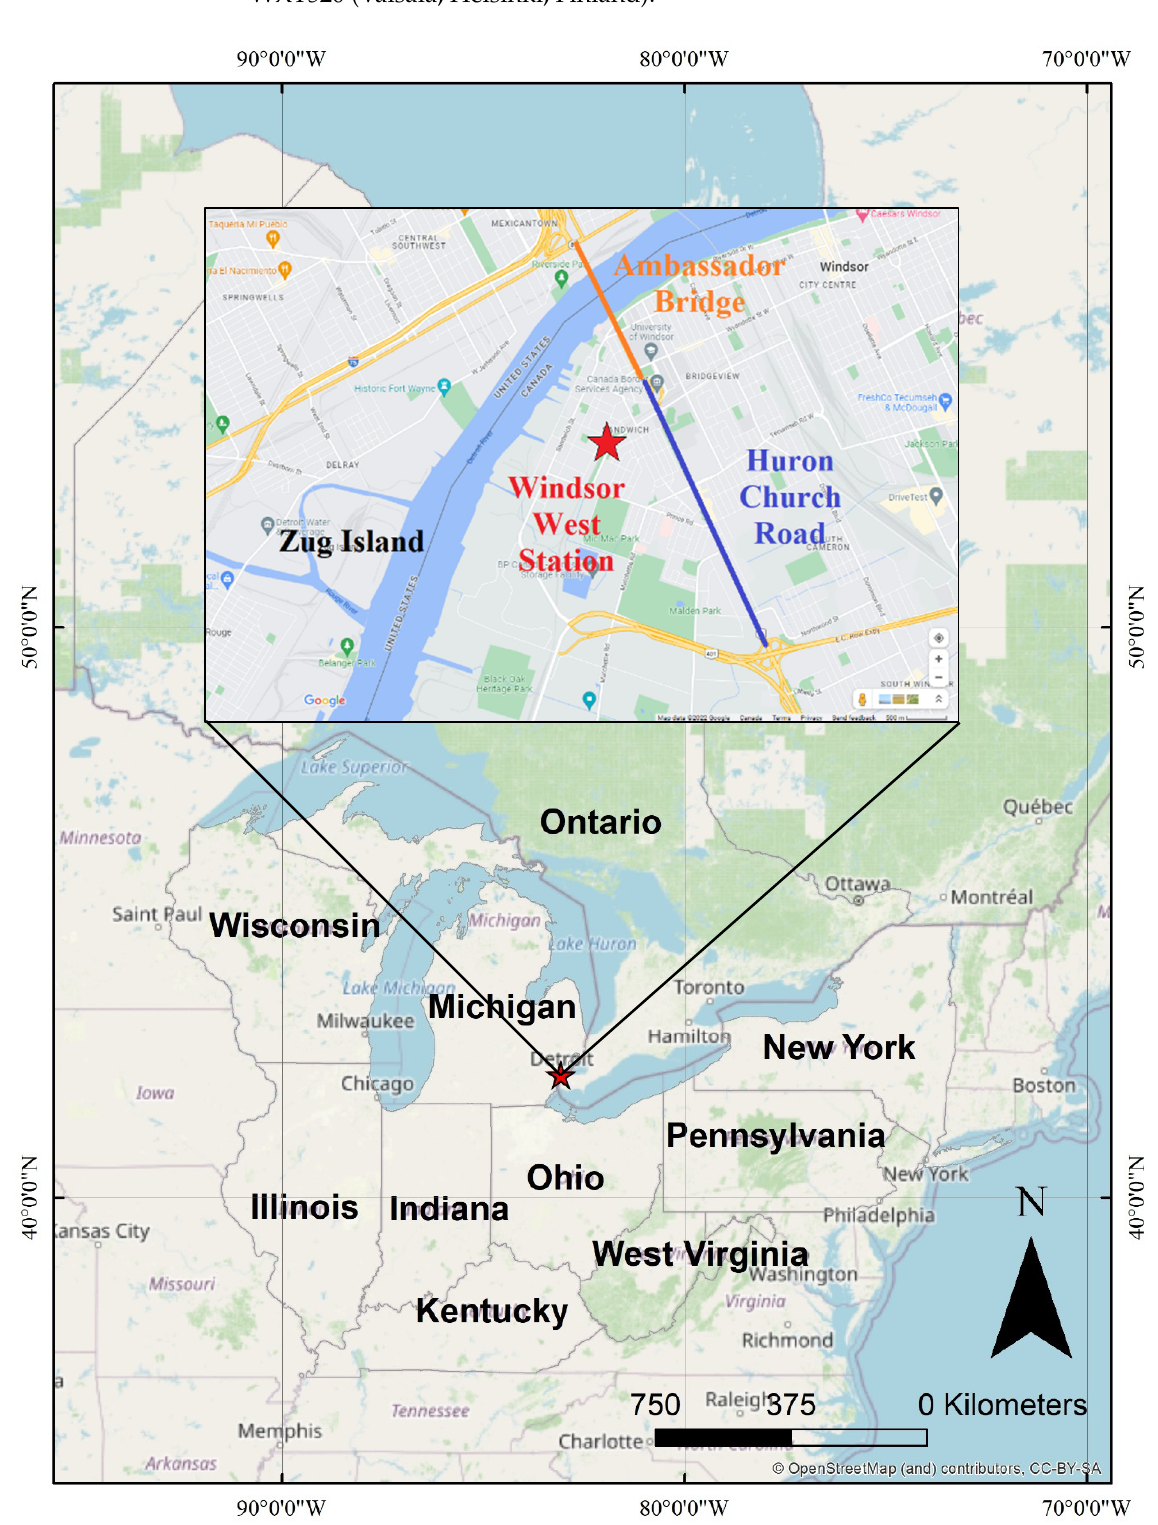
Figure 1. Location of the Windsor West air monitoring station in Ontario, Canada. Hourly concentrations of PM 2.5 were measured with the synchronized hybrid ambi- ent real-time particulate (SHARP) 5030 monitor (Thermo Fisher Scientific Corporation, Franklin, MA, USA). Hourly BC concentrations were monitored by the API 633 Magee